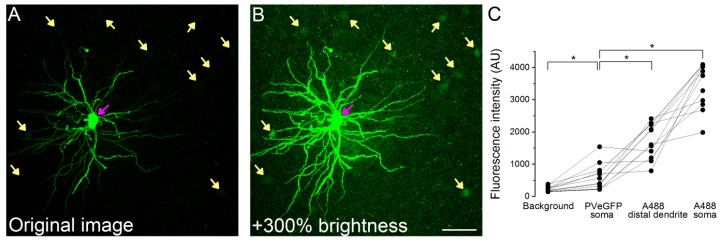
Subcellular compartments of Alexa488 filled and subsequently immunolabeled cells are readily distinguishable from eGFP signal in PV cell somata.(A) Original maximum z-intensity projection image of an Alexa488 labeled cell (magenta arrow) used for the analysis of the inhibitory contacts (labeled interneuron is not shown for clarity). (B) Same image with +300% brightness correction to show the faint eGFP signal (yellow arrows). (C) Comparison of the fluorescence intensity in the different structures (n = 12 A488 labeled PNs, in each Figure 5 distal dendritic segments, 5 eGFP labeled cells and five background areas were averaged). Note that 4095 AU value represents detector saturating intensity values. Scale bar: 50 µm.